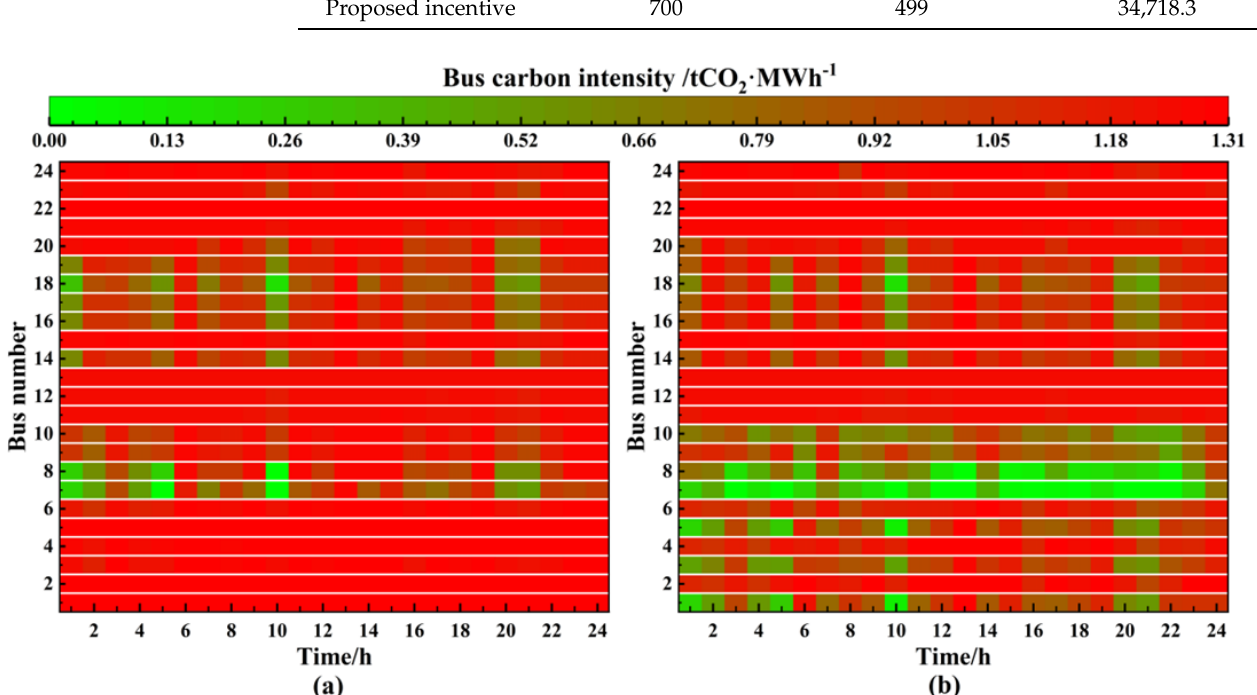
Figure 5. ( a ) Expectation of bus carbon intensity without incentive; ( b ) expectation of bus carbon intensity with the proposed incentive.